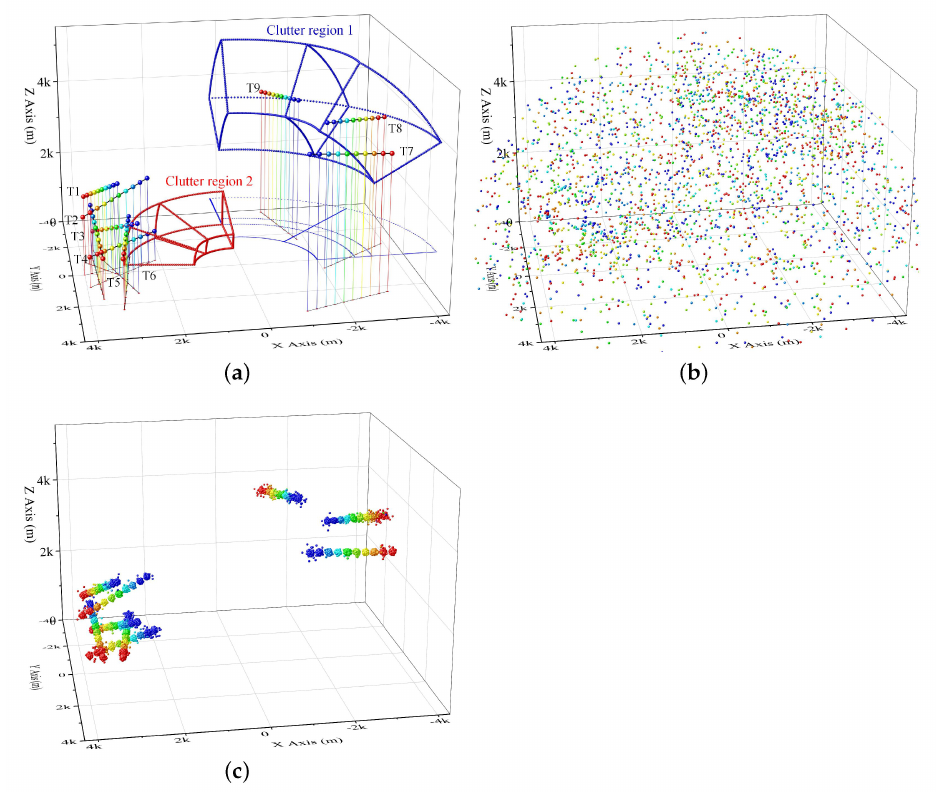
Figure 5. ( a ) The simulation scenario. ( b ) The measurements in one experiment. ( c ) The target points obtained from 200 Monte Carlo experiments (before trajectory smoothing). Table 4. Simulation